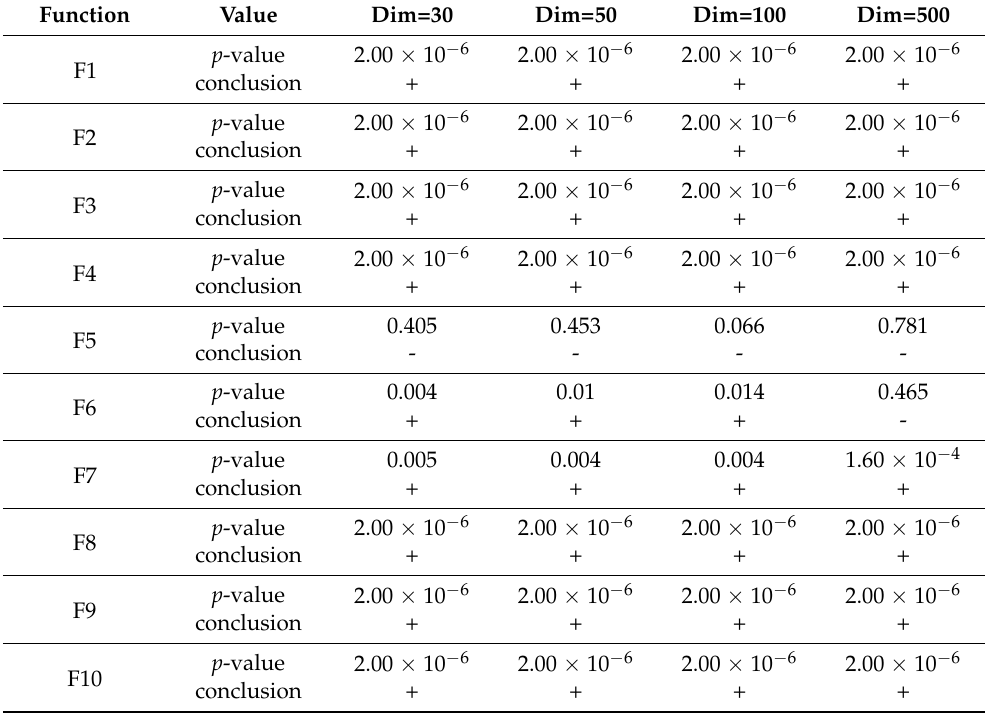
Table 10. Statistical results of Wilcoxon signed-rank test on unimodal functions.